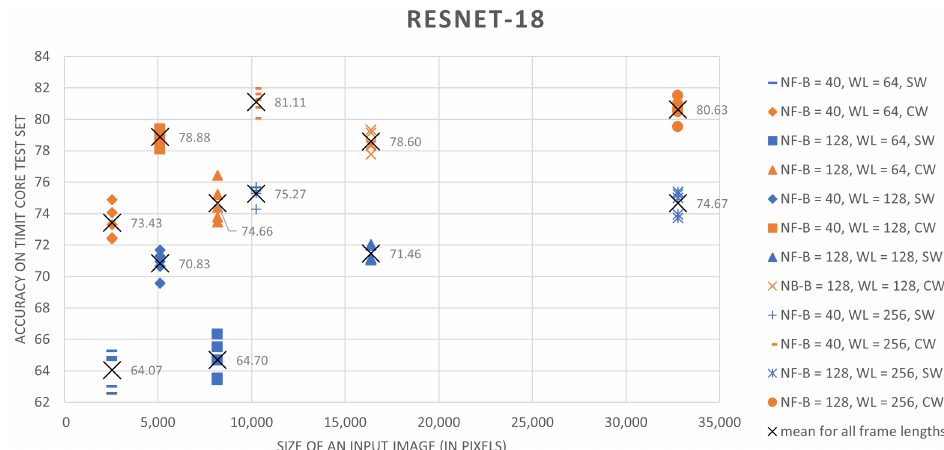
Figure 3. ResNet18 classification accuracies on the TIMIT core test set as a function of input image size. Models trained using datasets derived using a central-window scheme (CW) are shown in orange, while models trained on dataset prepared using sliding-window method (SW) are shown in blue. The presented point clusters correspond to different frame lengths.